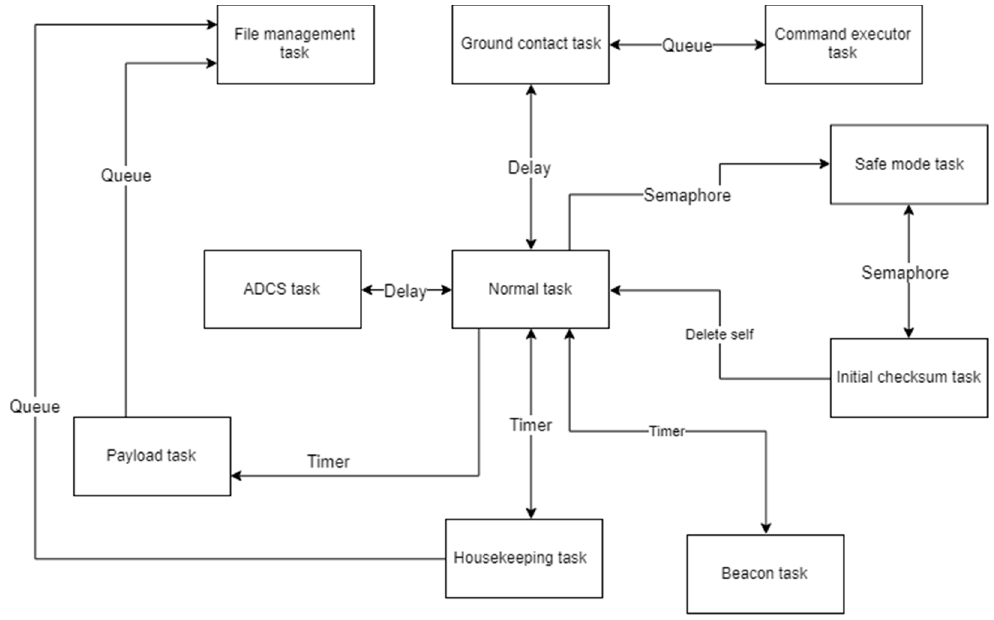
Figure 12. MeznSat software block diagram.